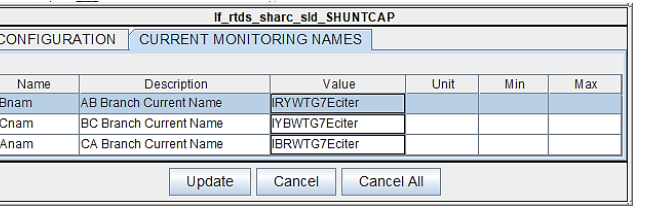
Figure 23. Induction generator exciter phase current signal settings for the calculation and monitoring of reactive power, exciter current , and voltage.